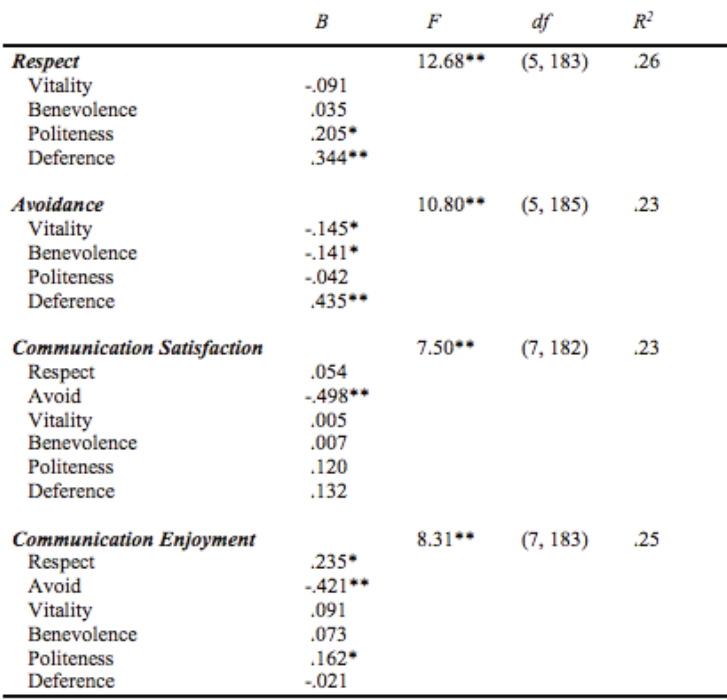
Regression Results for USA Data (Older Adult